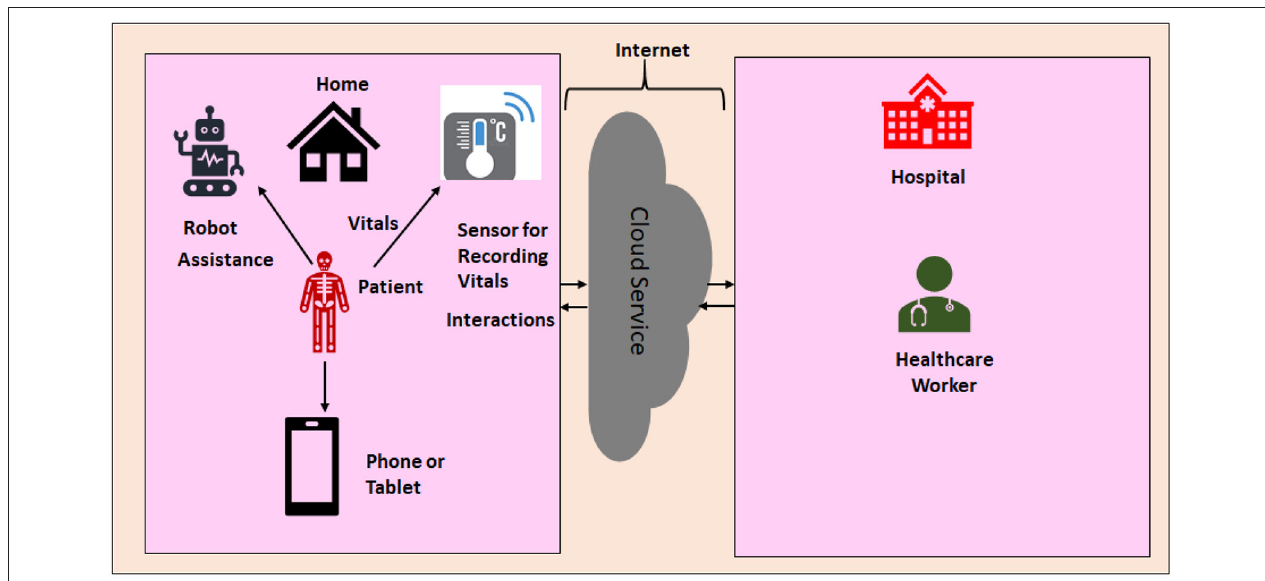
FIGURE 7 | A futuristic healthcare